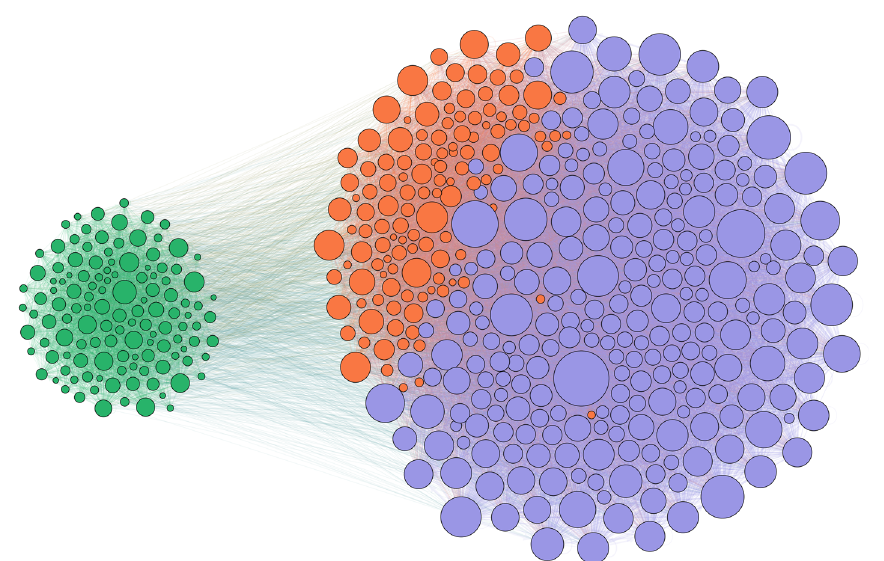
Fig. 5 Visualisation of a synthetic graph with N = 500 vertices and m = 40000 directed edges, obtained with the force-atlas2 layout. Vertices are separated into three blocks of different sizes, such that the largest block (250 vertices, in purple) is strongly connected with one of the smaller blocks (125 vertices, in orange). Both blocks are weakly connected to the third block, that is clearly separated (125 vertices, in green). The out-degree sequence of the graph follows an exponential distribution with parameter λ = N / m . The joint effects of the non-uniform degree sequence together with the asymmetric block structure makes the task of community detection on this graph particularly hard for standard